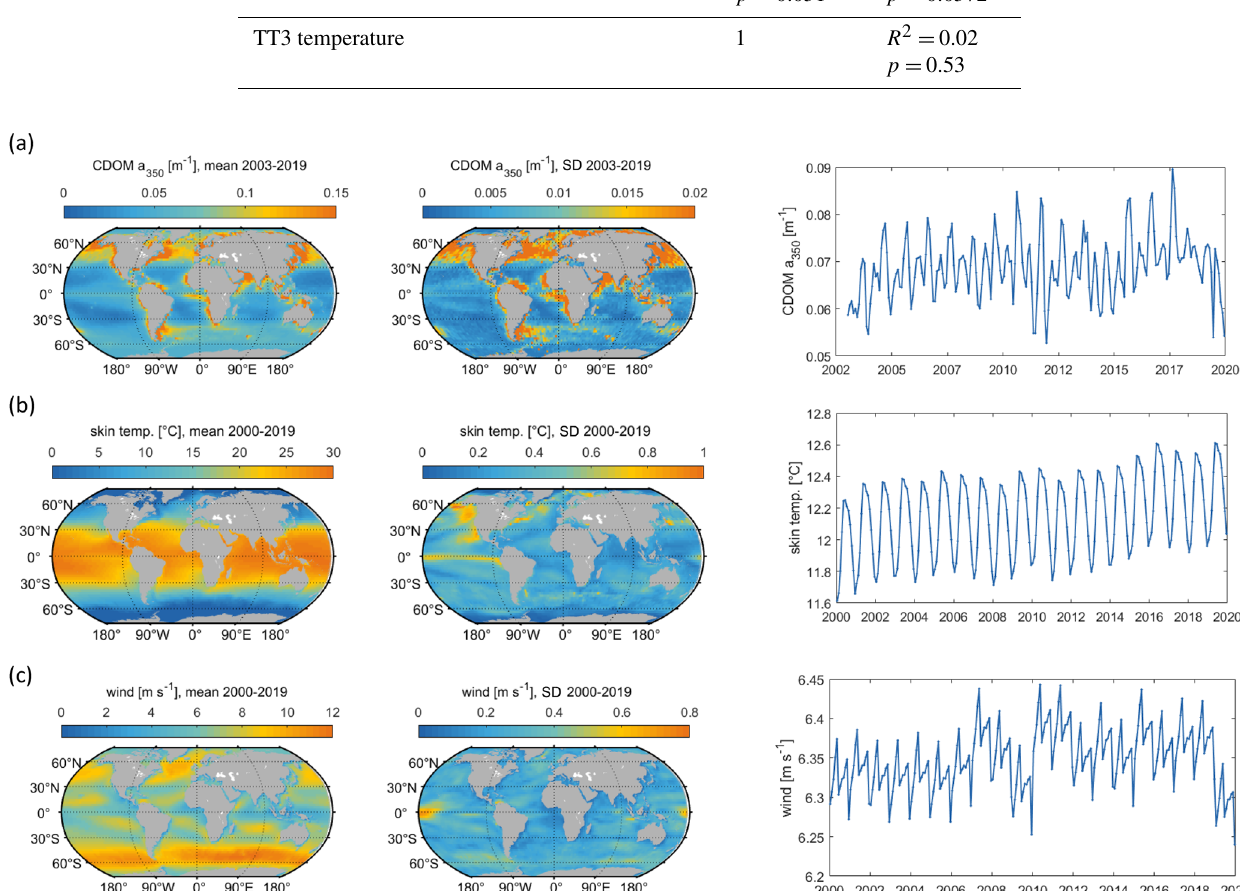
Figure 5. Mean and standard deviation (maps) and interannual variation (right panels) of model input parameters: (a) CDOM a350, (b) skin temperature, (c) wind speed. Data sources listed in Table